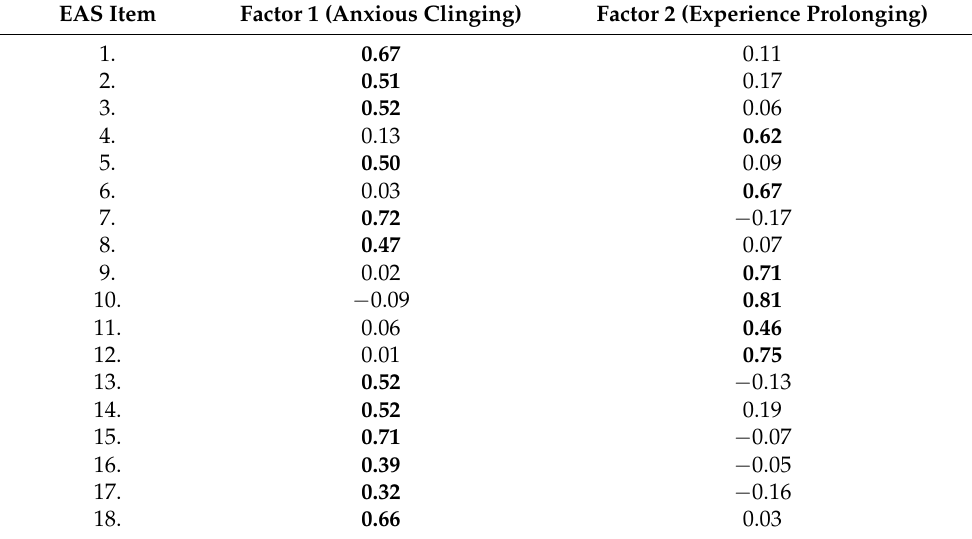
Table 2. Factor loadings for the EAS items.